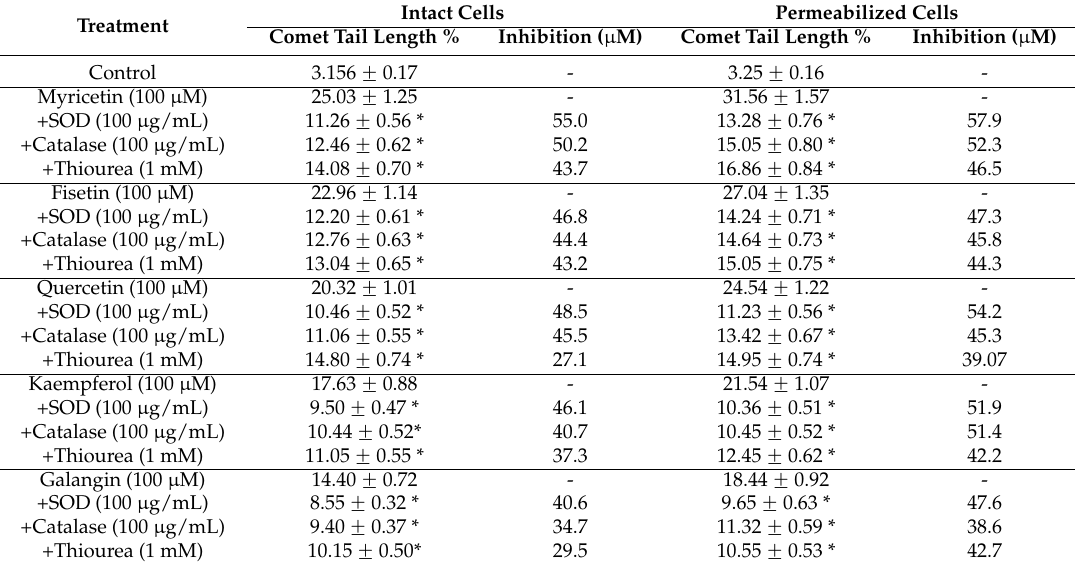
Table 2. Effect of scavengers of reactive oxygen species on flavonoid-induced cellular DNA breakage in permeabilized cells. * p < 0.05, compared with control (flavonoid only) cells. Data represent ˘ SEM of three independent